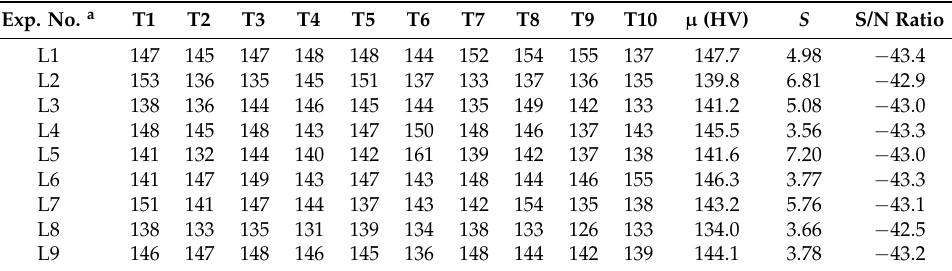
Table 5. The experimental results for hardness.